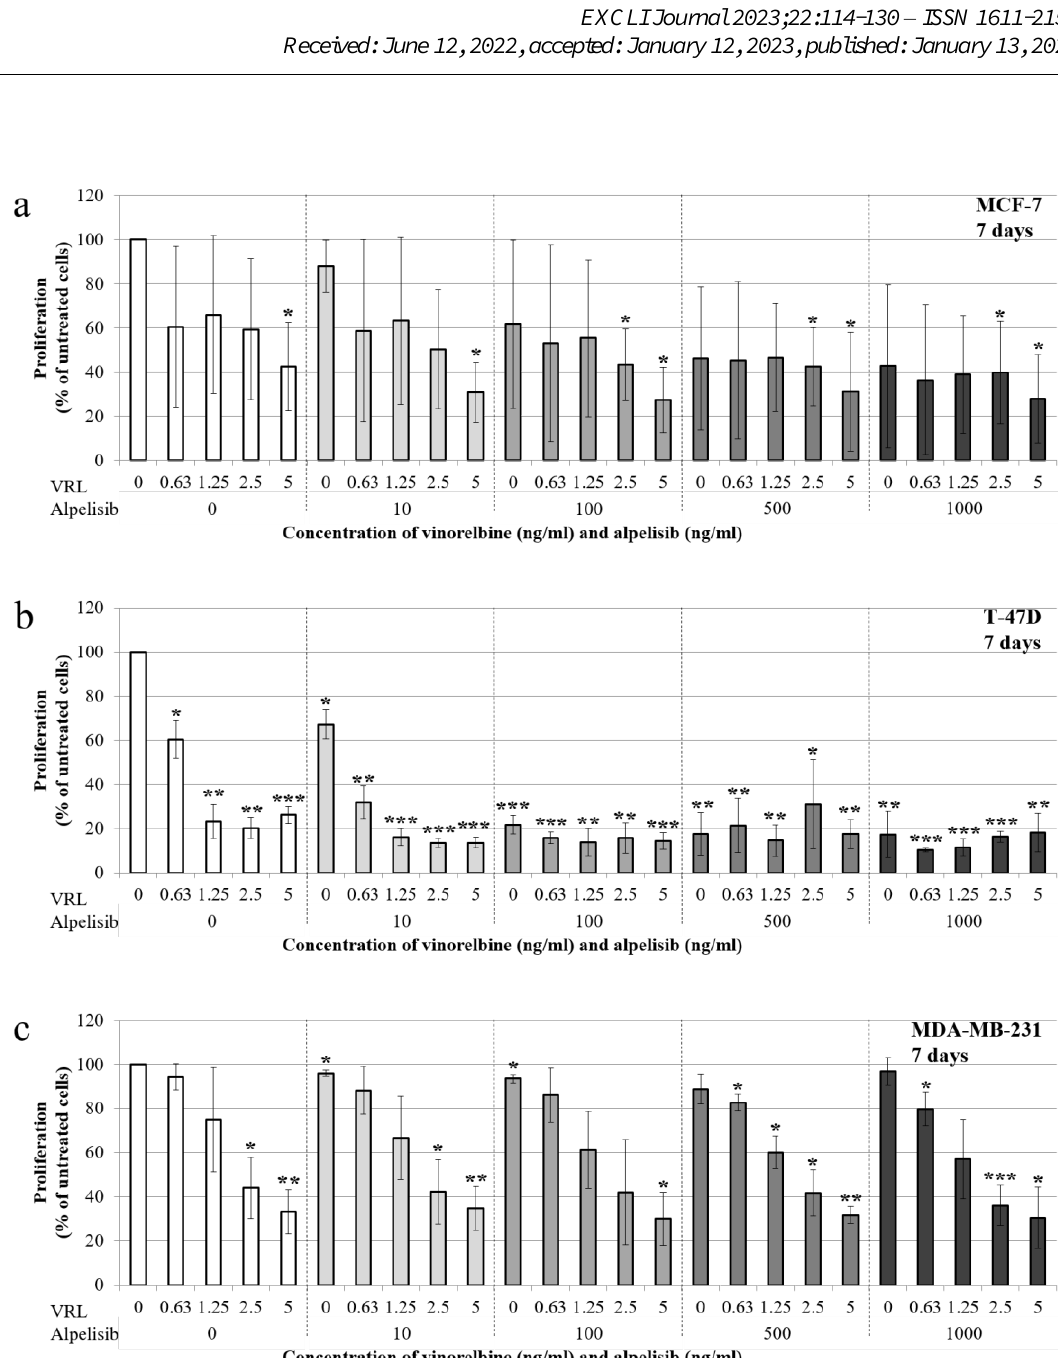
Figure 3: Effects of low-dose vinorelbine plus alpelisib on cell proliferation of the MCF-7 ( a ), T-47D ( b ) and MDA-MB-231 ( c ) cell line. BrdU incorporation was used to measure cell proliferation after 7 days of treatment with low-dose vinorelbine plus alpelisib. The results are shown as the mean ± standard devi- ation of three separate experiments. Statistical significance was assumed at * p<0.05, ** p<0.01 and ***